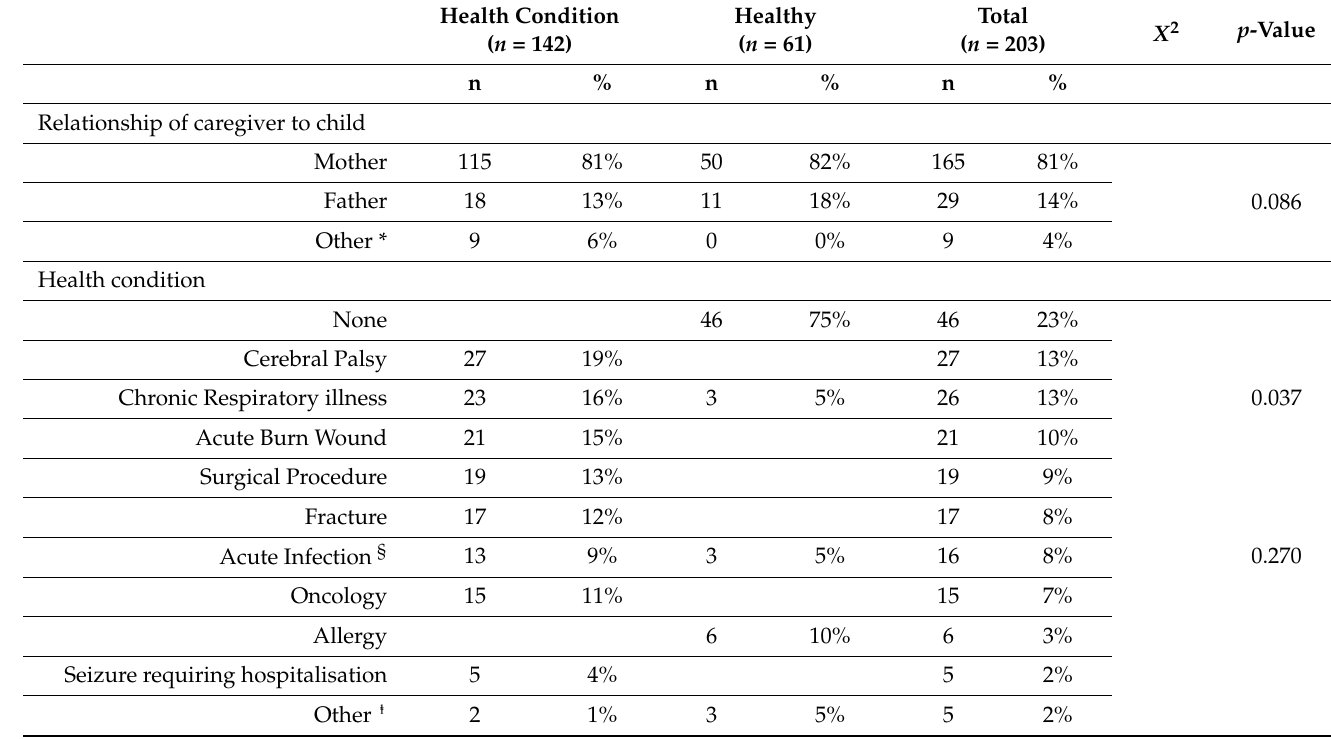
Table 1. Descriptive statistics of the sample (Total Sample N = 203).